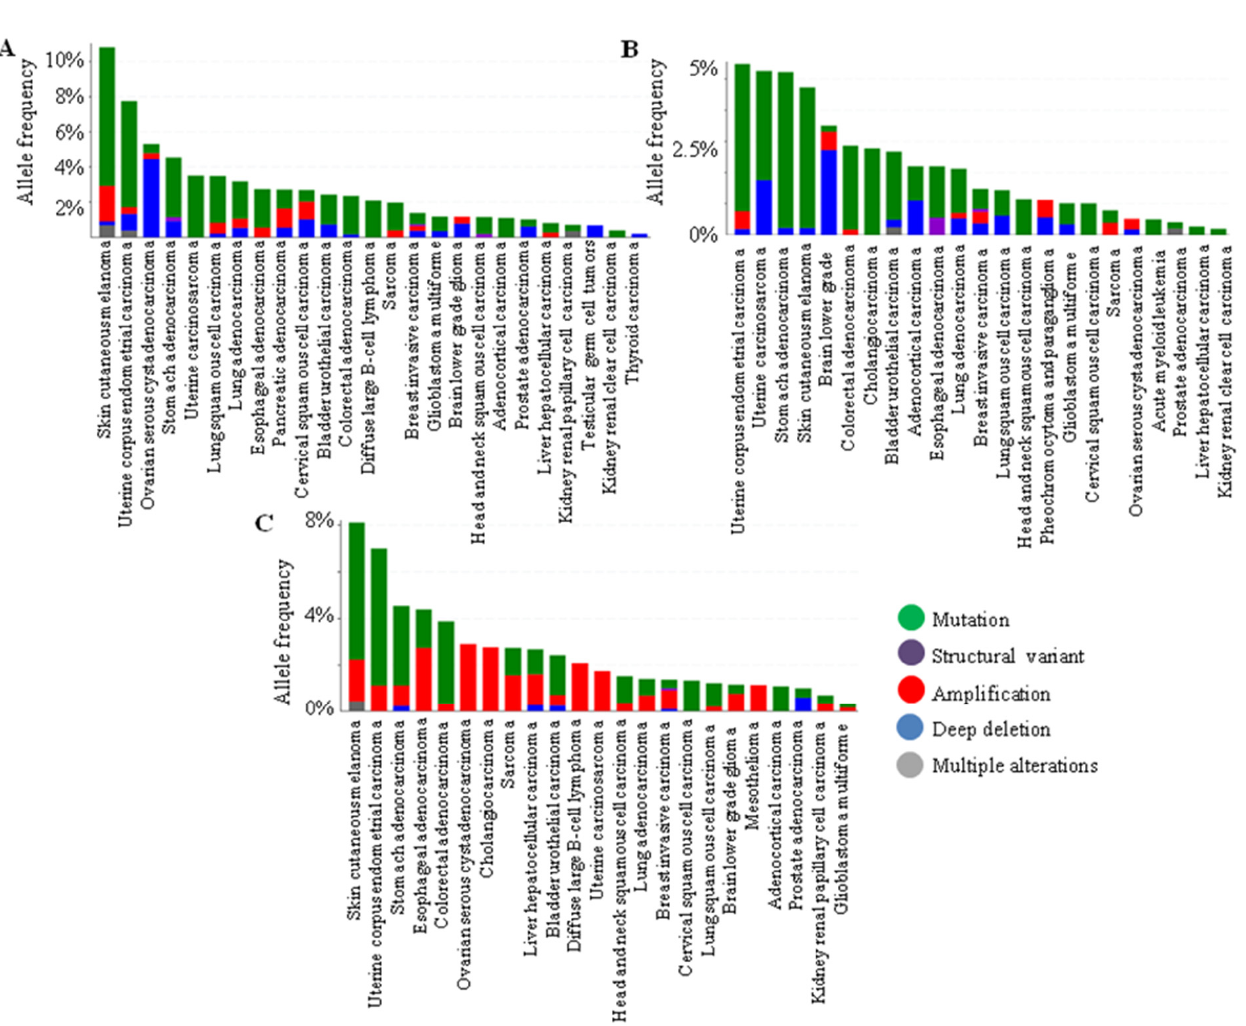
Figure 3. Genomic alteration in SCUBE family genes in various human cancers. Mutation and CNA data for SCUBE analyzed from 32 studies and 10,967 patient’s samples using cBioportal. ( A ) Data show the highest SCUBE1 gene alteration in skin cutaneous melanoma; ( B ) SCUBE2 shows the highest gene alterations in uterine corpus endometrial carcinoma; ( C ) SCUBE3 exhibits overexpression in skin cutaneous melanoma. Gene alteration is reported as amplification, deep deletion, mutation, structural variation, or multiple alterations.